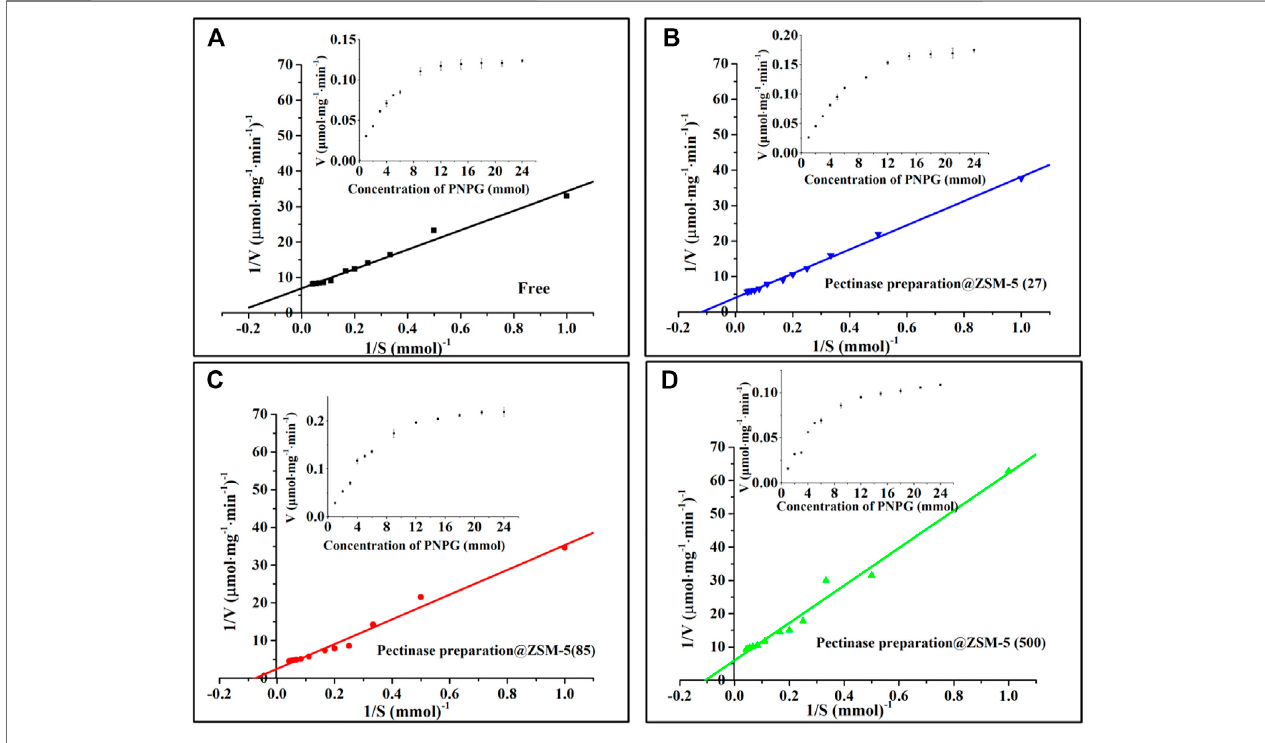
FIGURE 4 | Hanes – Woolf double-reciprocal plots: (A) free enzyme, (B) pectinase preparation@ZSM-5(27), (C) pectinase preparation@ZSM-5(85), and (D) pectinase preparation@ZSM-5(500). The inserts are substrate saturation curves for the enzyme-catalyzed reactions.